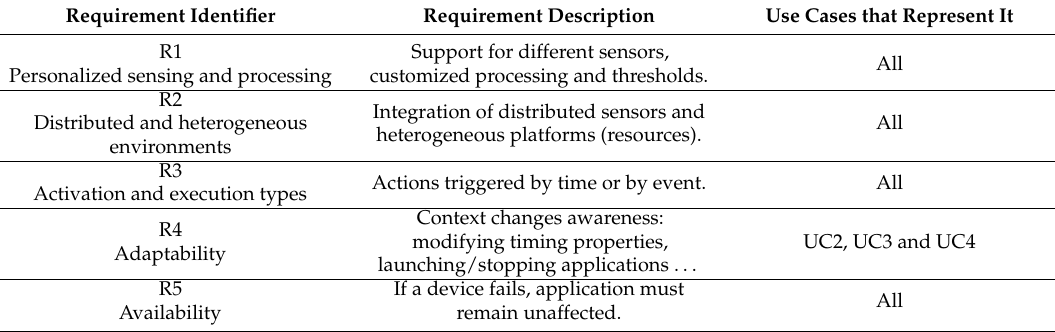
Table 1. Requirements demanded by the target applications and their relation with the proposed use